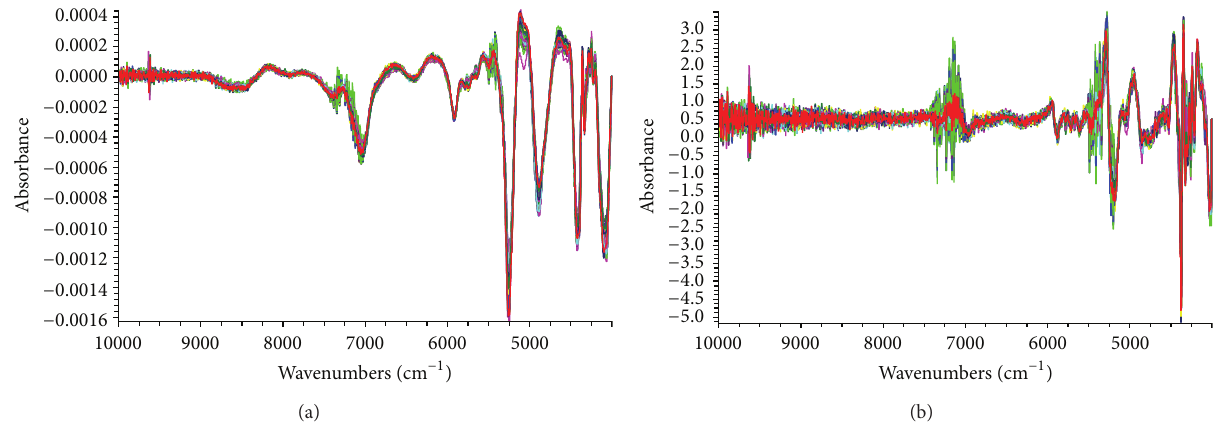
Figure 3: NIR spectra for ginseng samples processed by 1st derivative + SG + MSC (a) and MSC + SG + 2nd derivative (b).